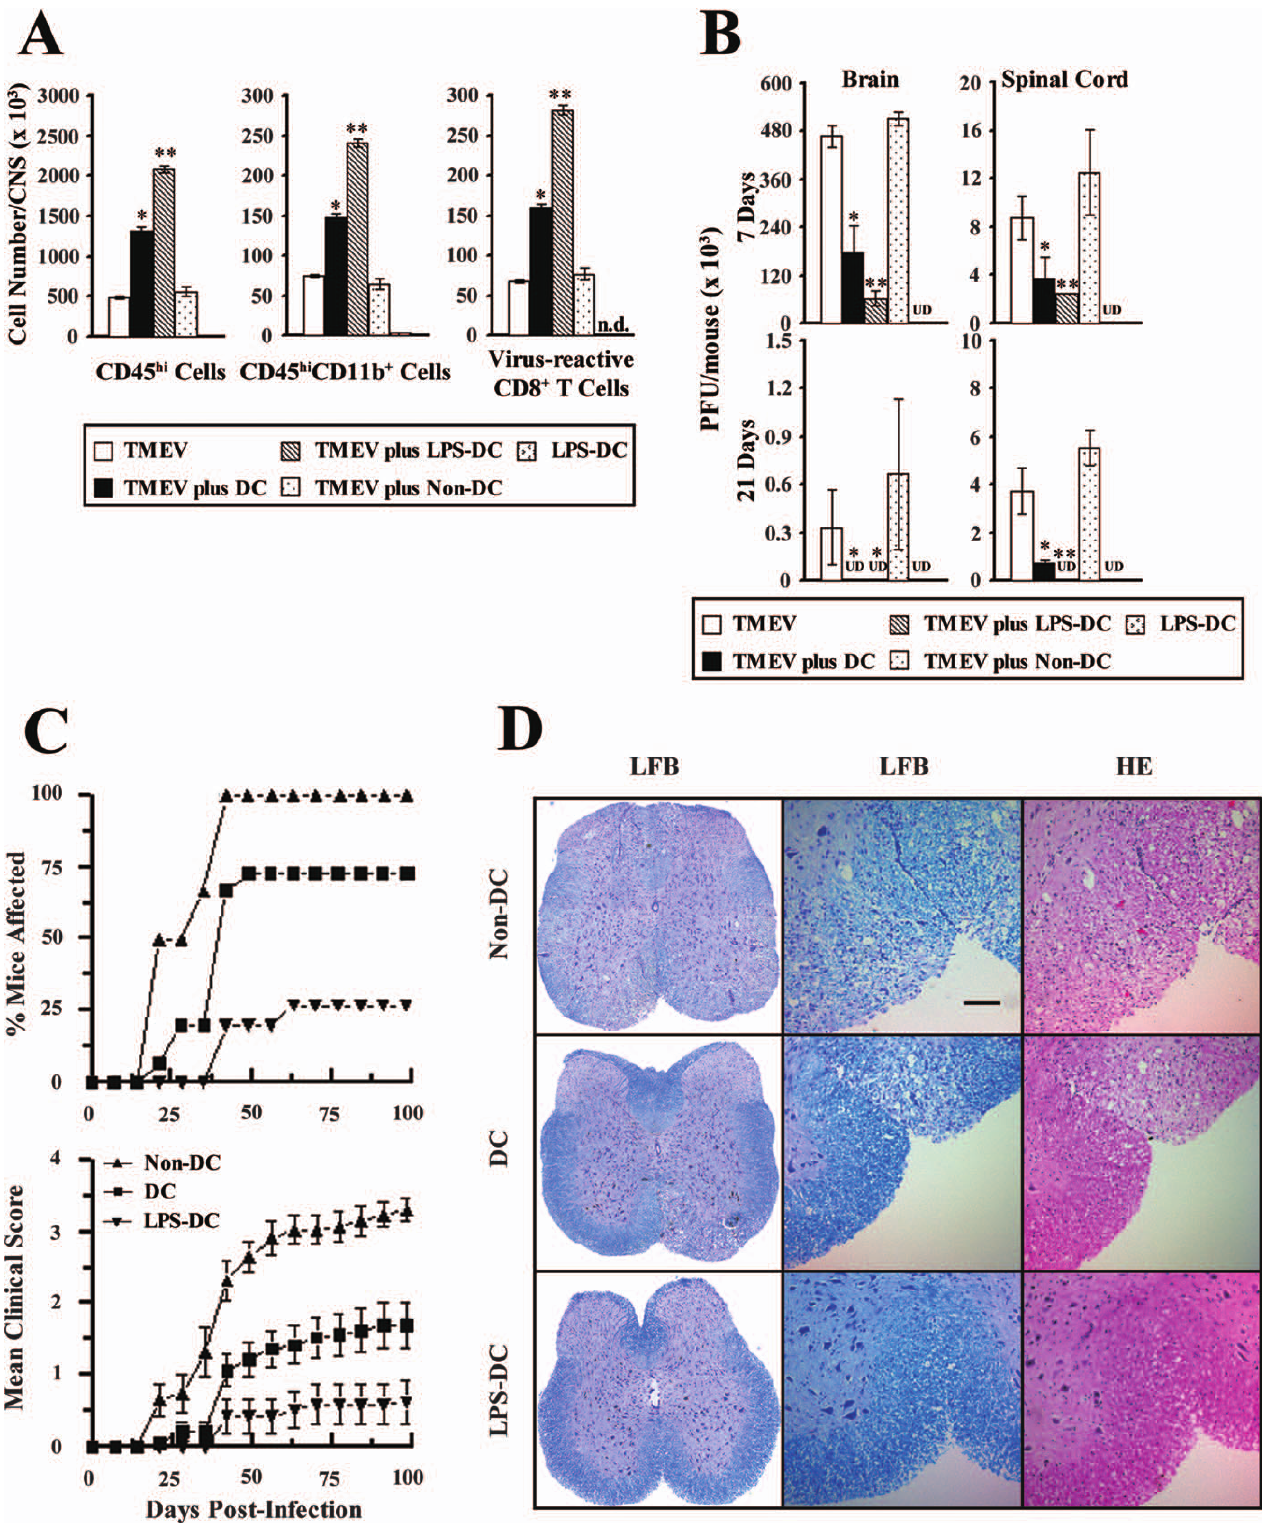
Figure 7. Enhanced CTL Responses, Viral Clearance, and Protection from Demyelinating Disease following DC Transfer into Susceptible Mice BM DCs pretreated with LPS for 6 h (LPS-DCs), untreated DCs, and non-DC splenocytes (1 3 10 5 cells/per mouse) together with TMEV (1 3 10 6 pfu/ mouse) or virus alone (no DC) were intracerebrally injected into SJL mice. (A) Assessment of levels of CD45 hi cells, CD45 hi CD11b þ cells, and virus-reactive CD8 þ T cells in the CNS of virus-infected mice (three mice per group) at 7 dpi. *, p , 0.05 and **, p , 0.01 compared to values in mice infected with virus alone. n.d., not done. (B) Level of viral persistence in brains or spinal cords (three mice per group) was assessed by plaque assay at 7 and 21 dpi. UD (undetectable) represents virus levels lower than 24 pfu/per tissue. *, p , 0.05 and **, p , 0.01 between the experimental groups and the control group infected with virus alone. PLoS Pathogens |